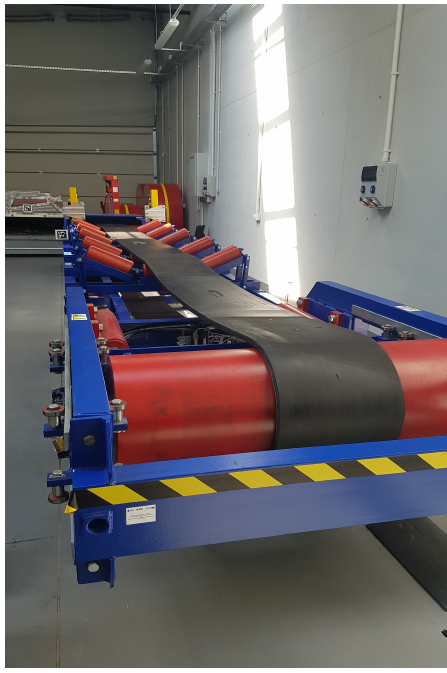
Figure 17. Belt conveyor test rig in GEO3EM Research Center.